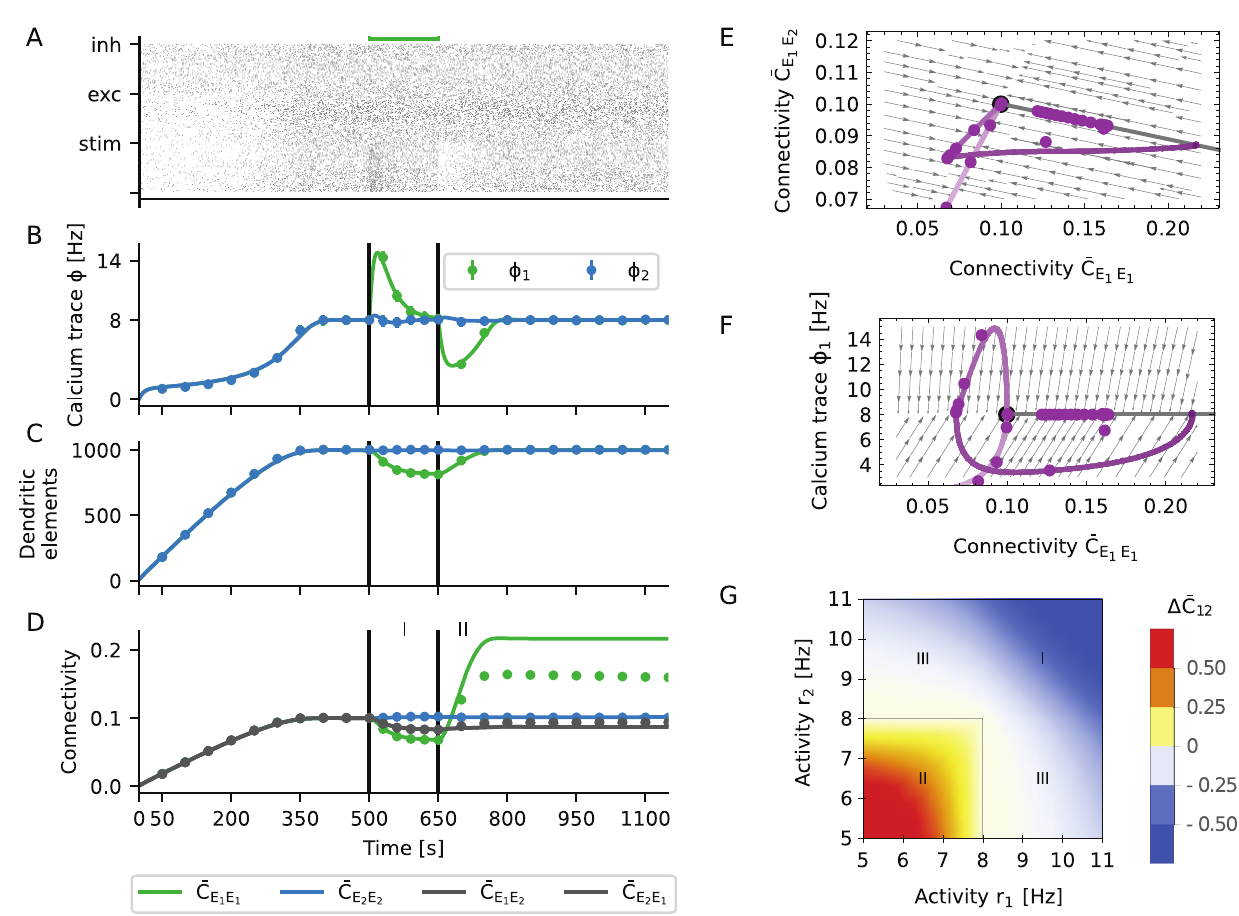
Fig 4. Hebbian properties emerge through the interaction of selective input and homeostatic control. (A) The activity of the neuronal network was subject to homeostatic control. For increased external input, it transiently responded with a higher firing rate. With a certain delay, the rate was down- regulated to the imposed set-point. When the stimulus was turned off, the network transiently responded with a lower firing rate, which was eventually up-regulated to the set-point again. The activity was generally characterized by irregular and asynchronous spike trains. (B) It was assumed that the intracellular calcium concentration followed the spiking dynamics, according to a first-order low-pass characteristic. Dots correspond to numerical simulations of the system, and solid lines reflect theoretical predictions from a mean-field model of dynamic network remodeling. (C) Dendritic elements (building blocks of synapses) were generated until an in-degree of K in = 1000 was reached. This number slightly decreased during specific stimulation, but then recovered after the stimulus was removed. (D) Synaptic connectivity closely followed the dynamics of dendritic elements until the recovery phase, when the recurrent connectivity within the stimulated group E 1 overshooted. (A–D) Black vertical lines indicate beginning and end of the stimulation. (E, F) Phase space representation of the activity. The purple lines are projections of the full, high-dimensional dynamics to different two-dimensional subspaces: (E) within-engram connectivity vs. across-ensemble connectivity and (F) within-engram connectivity vs. engram calcium trace. The dynamic flow was represented by the gray arrows. The steady state of the plastic network was characterized by a line attractor (thick gray line), defined by a fixed total in-degree and out-degree. The ensemble of stimulated neurons formed a stable engram, and the strength of the engram was encoded by its position on the line attractor. (G) The effective “instantaneous” learning rule for the expected connectivity between a pair of neurons is homeostatic in nature. It could also be viewed as an “inverse covariance rule” with baseline at the set-point of the homeostatic controller. The emerging Hebbian properties results from the more long-term combinatorial properties of rewiring across the whole network.